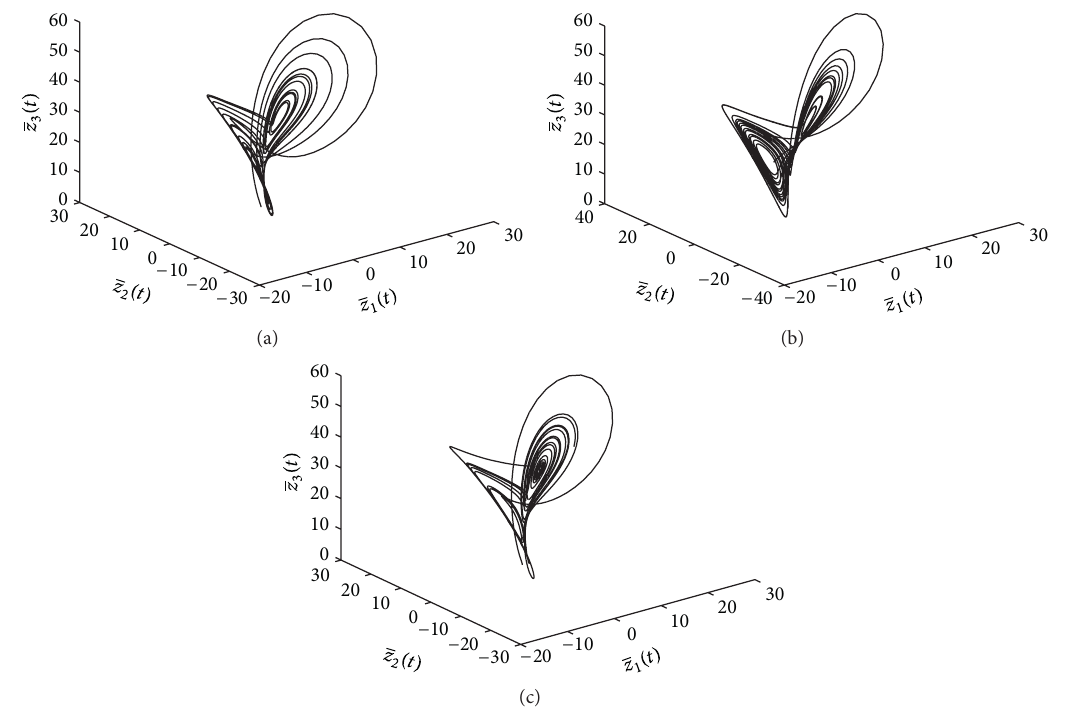
Figure 2: Chaotic trajectories of (46) with 𝜎 1 (𝑡) (a), 𝜎 2 (𝑡) (b), 𝜎 3 (𝑡)